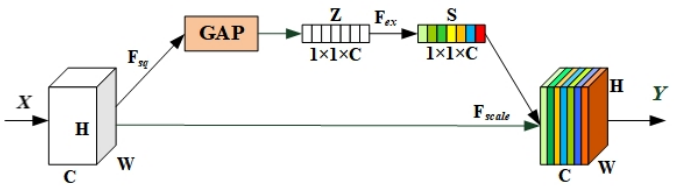
Figure 5. The sketch map of attention mechanism.